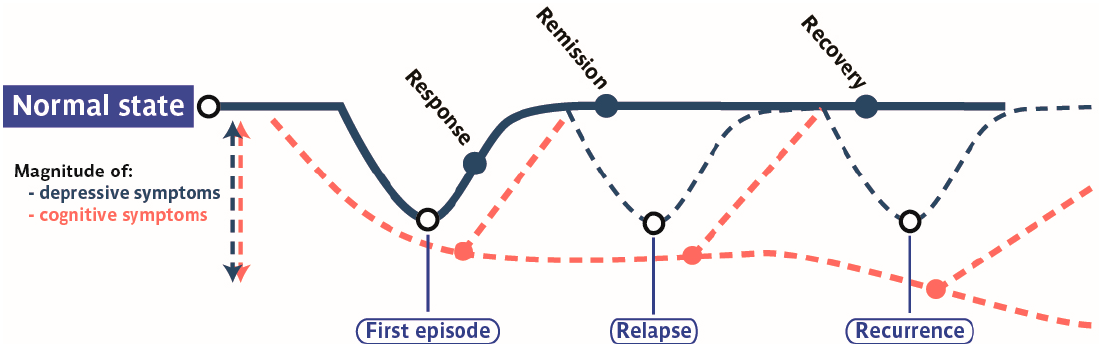
Figure 1. Schematic representation of a common trajectory towards chronic recurrent depression. Blue full and dotted lines represent various forms of progressions of depressive symptoms during the course of MDD. The red dotted line represents the magnitude of cognitive symptoms associated to MDD pathology according to MDD state. An early onset of cognitive symptoms depression has been reported before the clinical diagnosis. Those cognitive signs can persist even after remission or recovery of MDD symptoms.